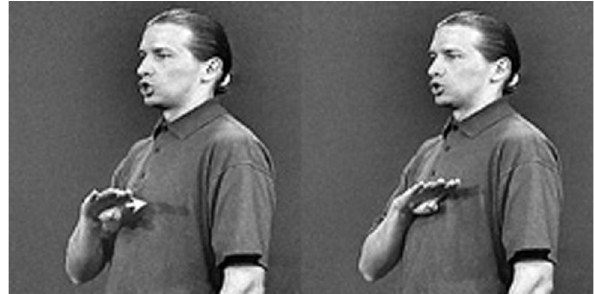
Figure 1: OLLA ( Suvi 2003 [ Finnish Sign Language dictionary ] : entry 250 ) .